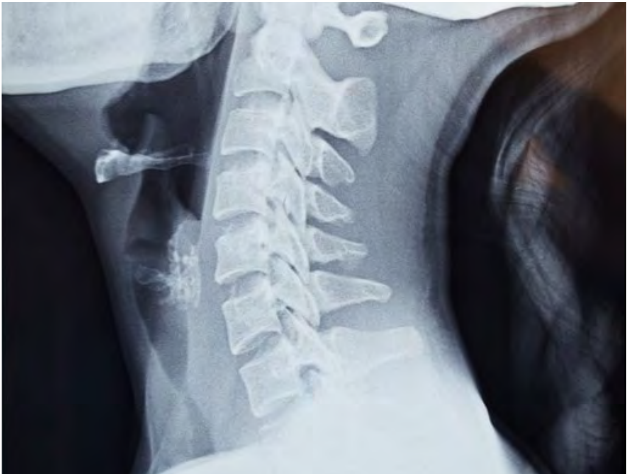
Fig 1 : X-ray of soft tissue neck, lateral-view showing tracheal stenosis at